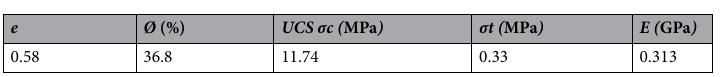
Table 2. Physical and mechanical characteristics of the samples. Reference 21